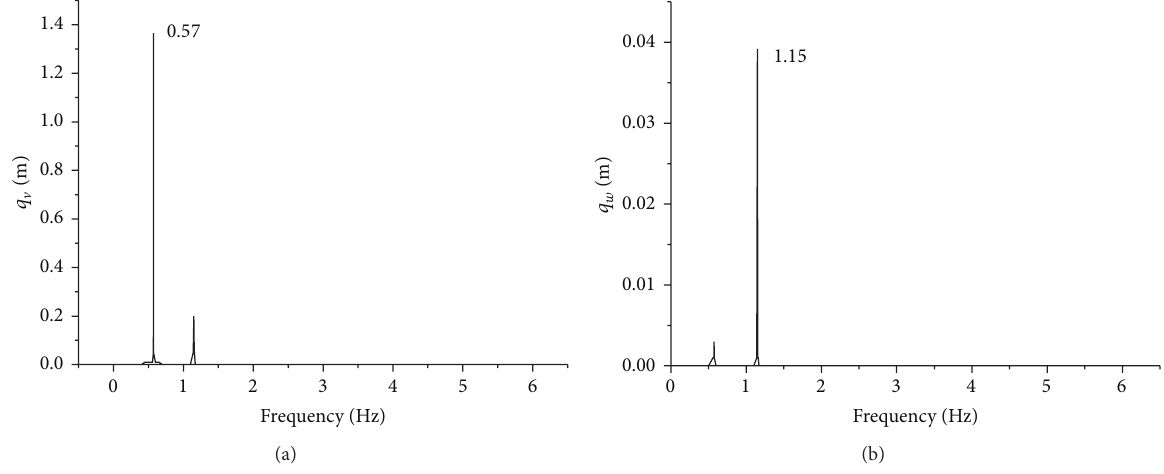
Figure 5: The amplitude-frequency spectrum of numerical solutions ( 𝑈 = 9